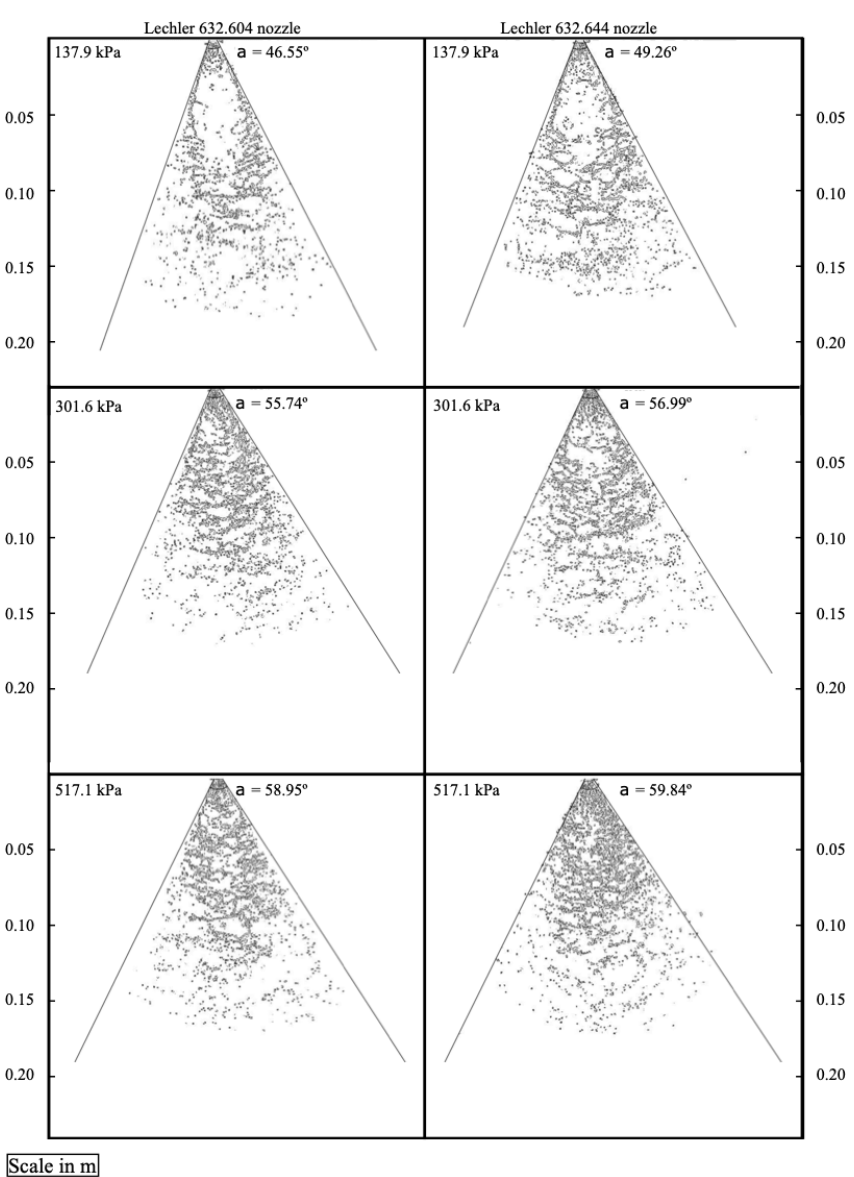
Figure 6. Shape and expansion angle of the nozzle at different pressures, with spray distance in ordinate axis.